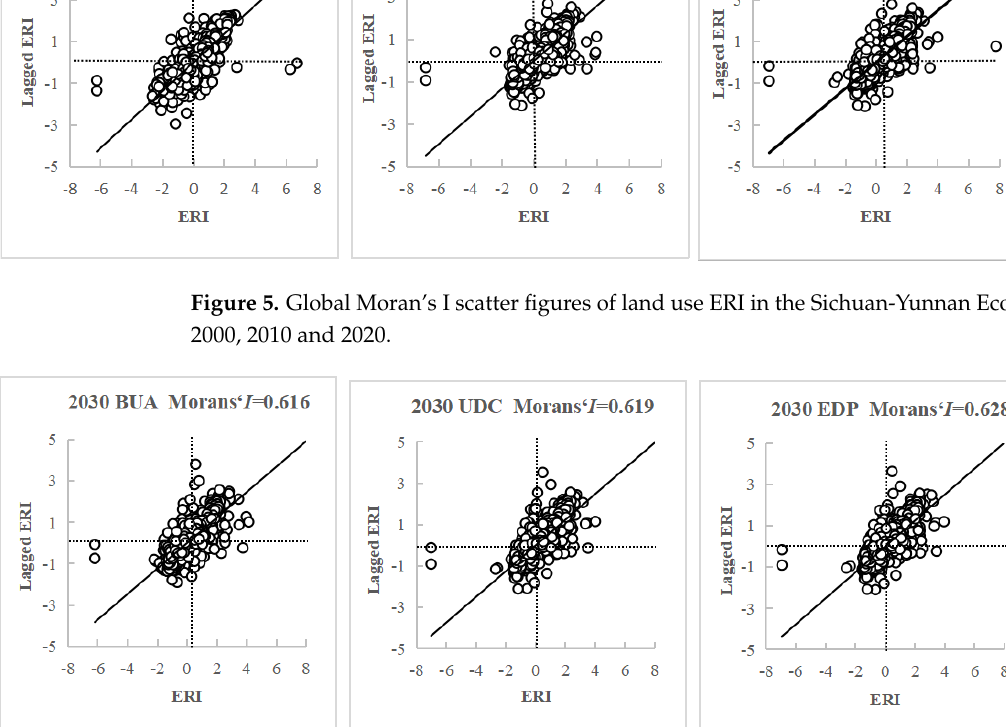
Figure 6. Global Moran’s I scatter figures of land use ERI in the Sichuan−Yunnan Ecological Barrier in three scenarios (BAU/UDC/EDP).